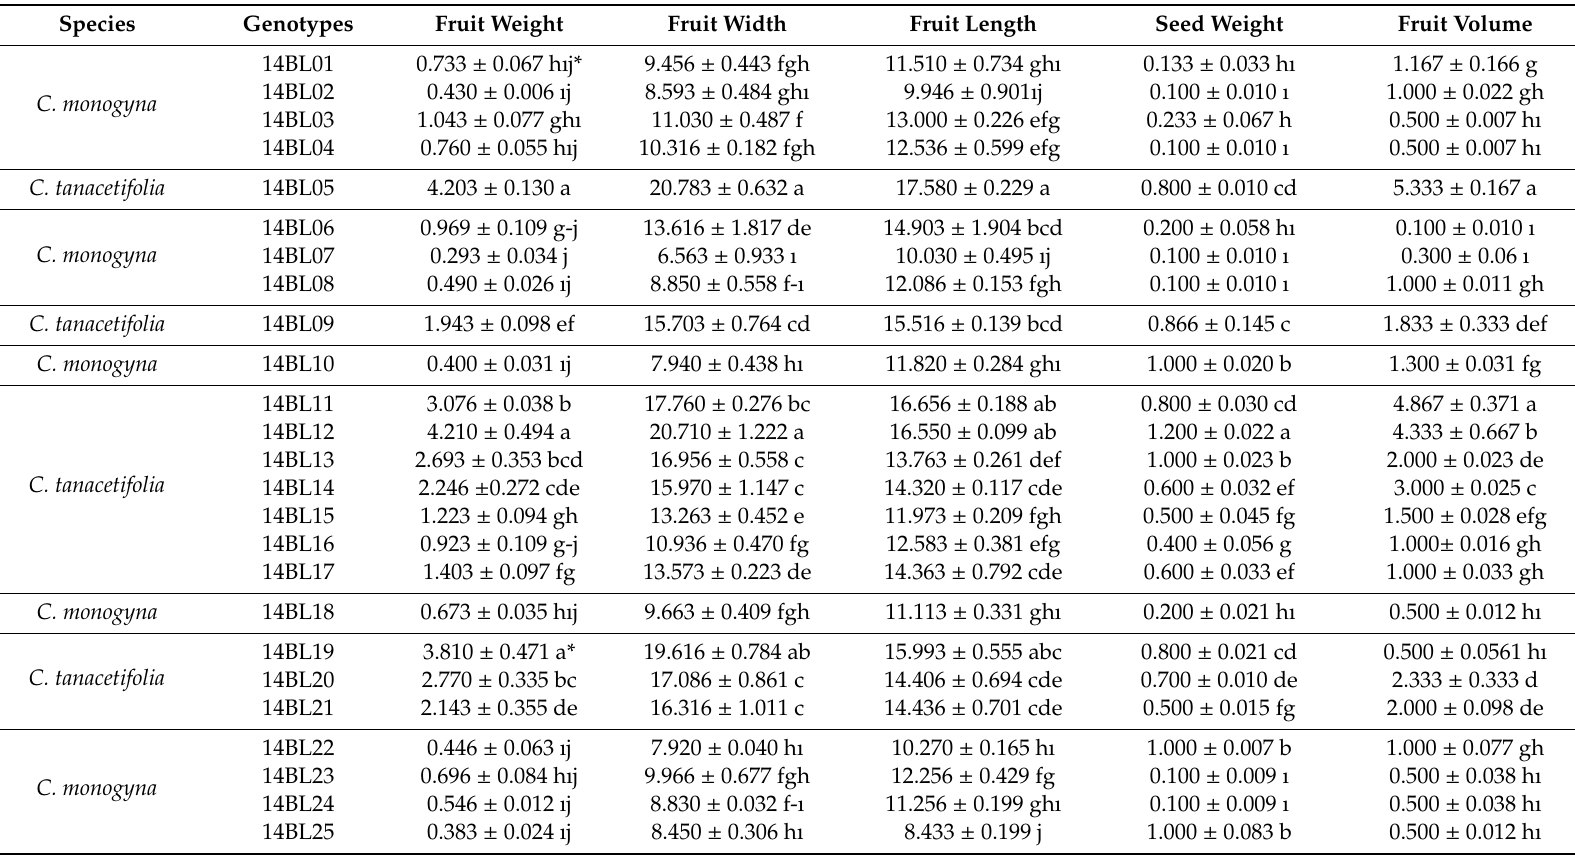
Table 3. Fruit weight (g), fruit width and length (mm), seed weight (g) and fruit volume (mL) of hawthorn